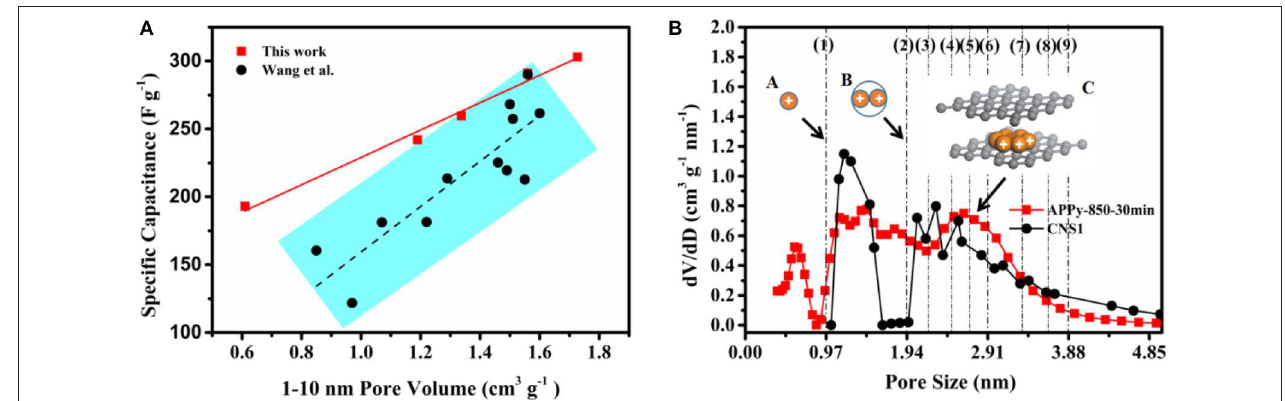
FIGURE 5 | (A) Relationship between pore volume and specific capacitance, (B) Pore size distribution curve calculated using different models and charge ion-packing configurations. Note: CNS1 stands for carbon nanosponge (CNS), which carbonized at 650 ◦ C, followed by activation at 900 ◦ C for 60min. The data of CNS1 are cited from Wang et al.